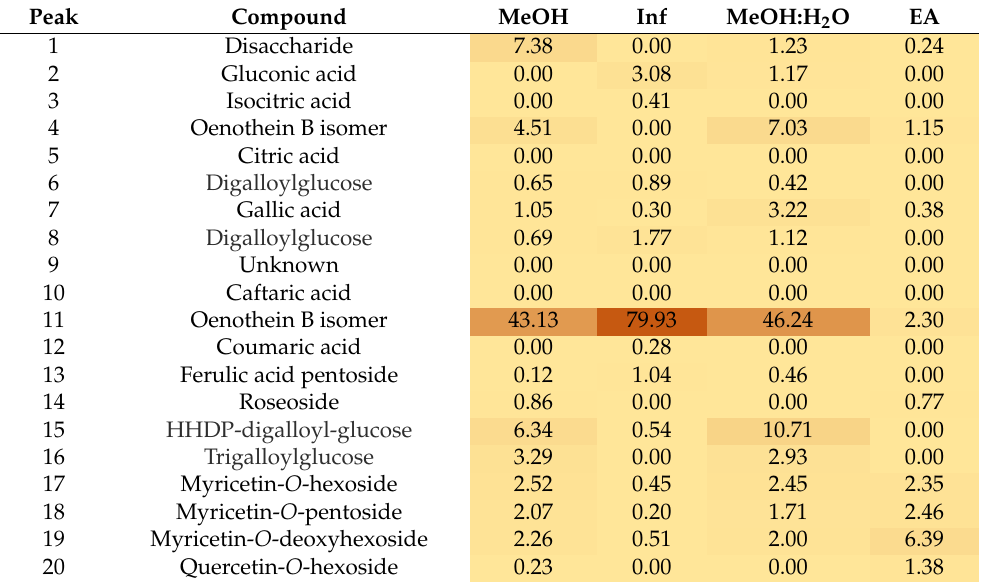
Table 4. Relative peak areas and heat map of extracts of the roots of Epilobium hirsutum *.